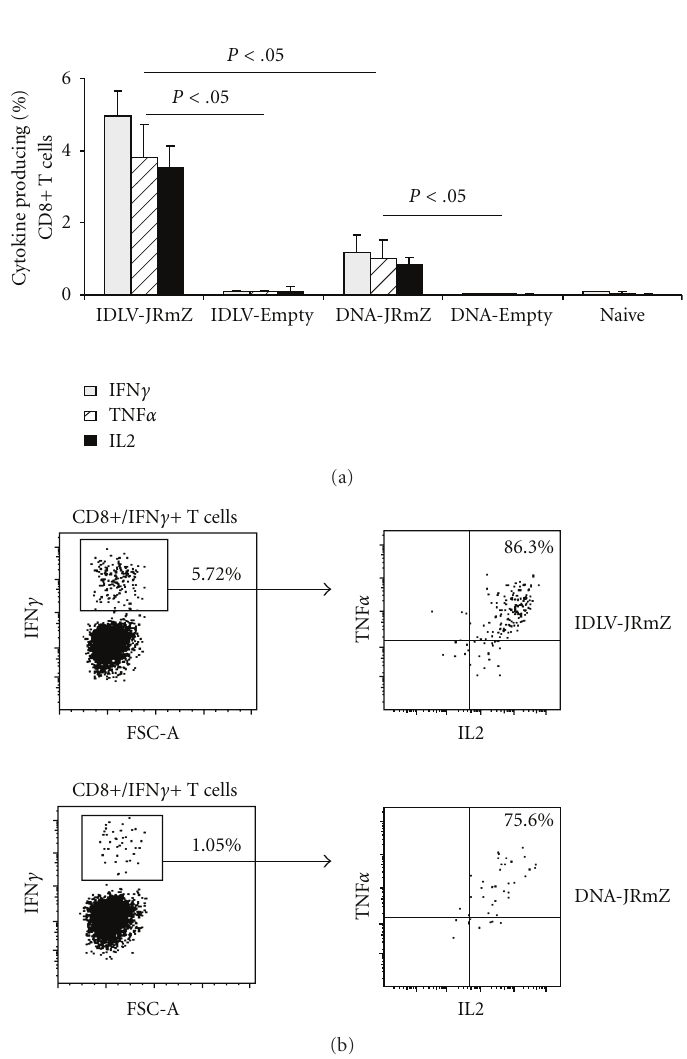
Figure 4: Analysis of cytokine production by intracellular staining (ICS). Results from one representative experiment out of three independent experiments are shown. (a) Splenocytes from mice immunized with IDLV-JRmZ, DNA-JRmZ, IDLV-Empty, and DNA-Empty or from na¨ıve mice were cultured in vitro with Envelope-specific JR-9mer peptide and then stained for IFN γ , TNF α , and IL2. Error bars indicate the standard deviation among four mice of the same group. Data are expressed as percentage of single cytokine-producing T cells by gating the CD8+ T cell population. (b) IDLV-JRmZ vaccination induced high frequency of polyfunctional antigen-specific CD8+ T cells able to simultaneously produce IFN γ , IL2, and TNF α . A representative experiment is shown. The analysis was performed on CD8+ T cells from the mice immunized with IDLV-JRmZ (upper panels) or DNA-JRmZ (lower panels). CD8+/IFN γ -producing cells were gated and analyzed for the production of both TNF α and IL2. Within the dot plots the percentages of single (IFN γ ) and double (TNF α and IL2) cytokine-producing CD8+ T cells are indicated. FSC: forward